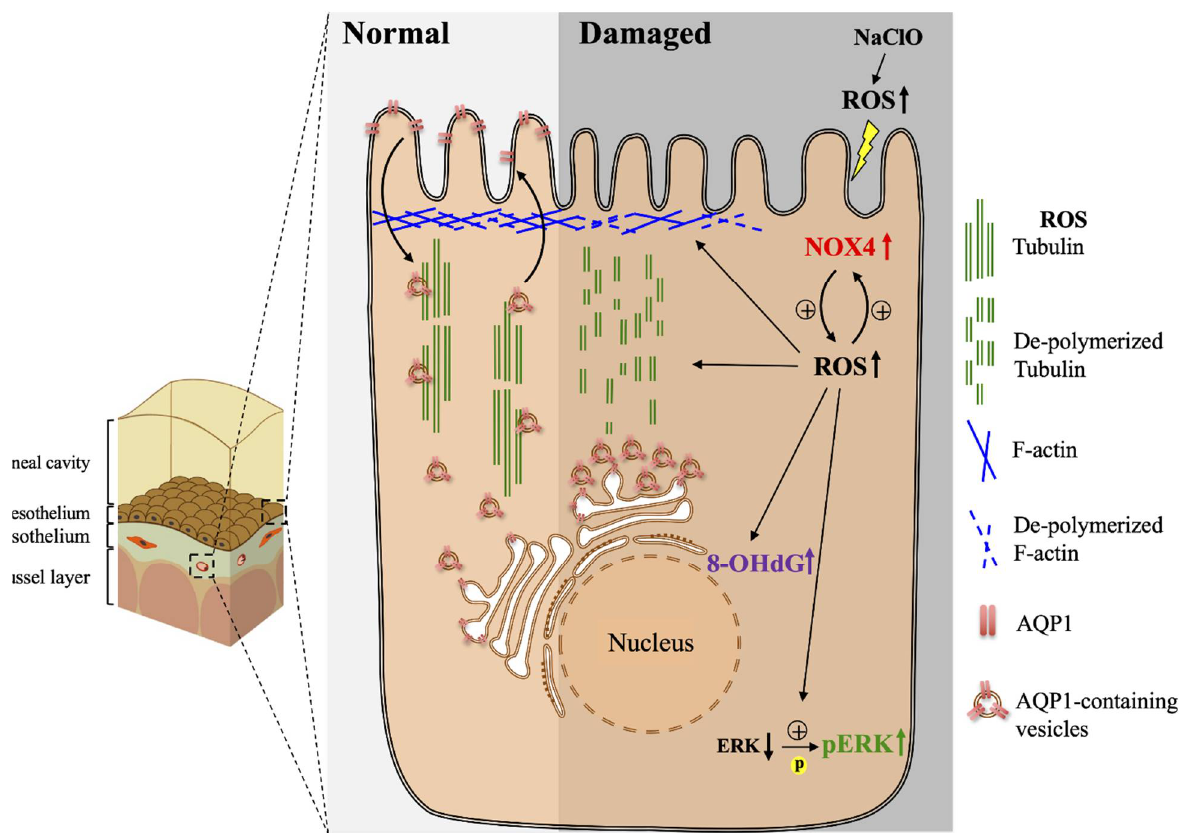
Figure 7. Summarized model for oxidative stress-induced disruption on the cellular transport of AQP1. Upon NaClO stimulations, direct and indirect production of excessive ROS activated NOX4 associated signaling pathways and promoted phosphorylation of ERK, which subsequently enforced a positive feedback loop in producing ROS. Accumulation of ROS led to oxidative stress and enhanced depolymerization of the cytoskeleton. Disruption of both actin and tubulin interfered with intracellular transport of AQP1 from the endoplasmic reticulum to the cell membrane. Failure for AQP1 to reach the cell membrane resulted in the impairment of water transport, which led to the loss of sodium sieving on PET.